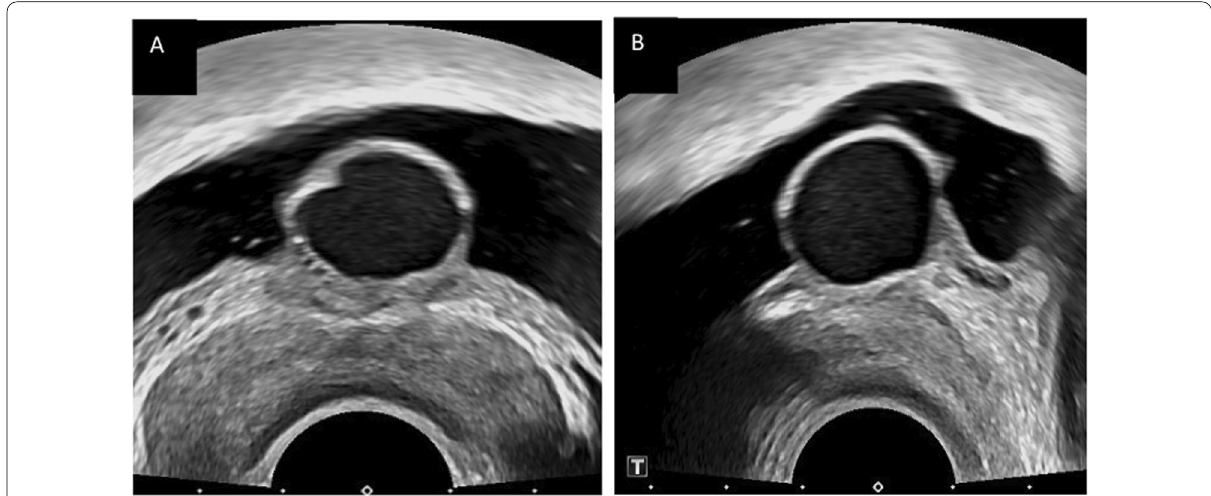
Fig. 1 Axial ( A ) and sagital ( B ) images of TRUS showing an anteriorly placed midline prostatic cyst projecting at the bladder neck region measuring (1.4 1.1 ×